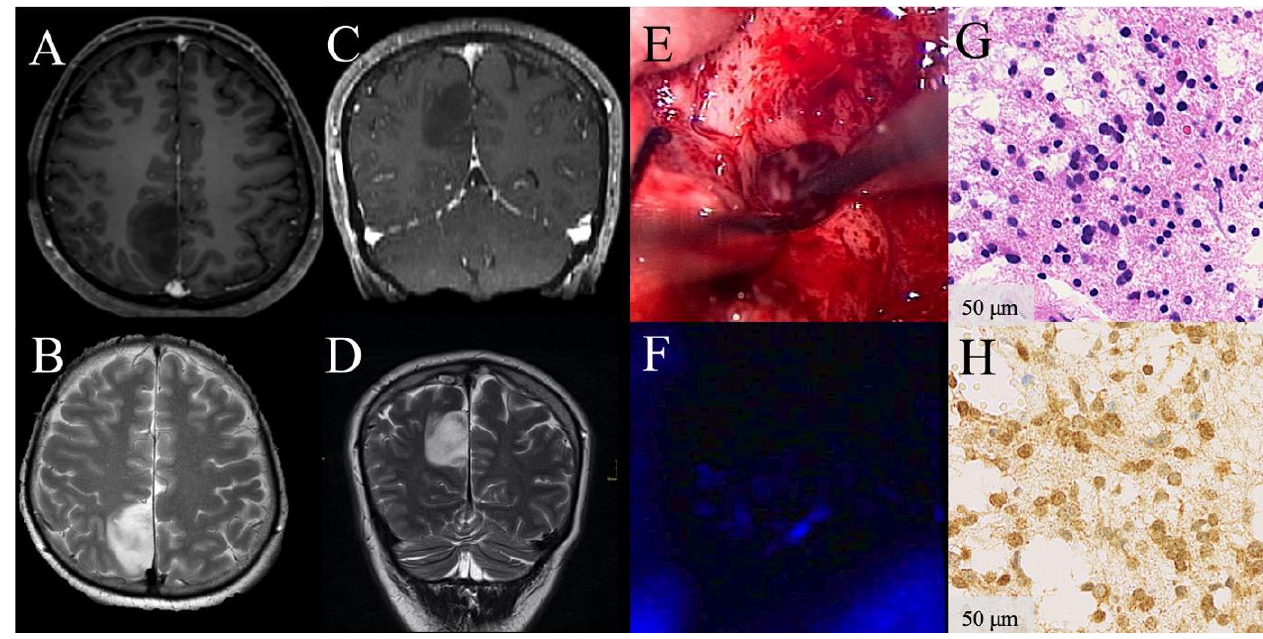
Figure 1. Illustrative clinical course of a patient with absence of visible 5-aminolevulinic acid (5-ALA) florescence during surgery of a low-grade glioma. Preoperative contrast-enhanced (CE) magnetic resonance images demonstrate a radiologically suspected LGG in the parietal lobe with patchy/faint CE on T1-weighted axial ( A ) and coronal images ( C ) and hyperintensity on T2-weighted sequences ( B , D ). Under white-light microscopy whitish glioma tissue is shown ( E ). Under violet-blue excitation light, no 5-ALA fluorescence is visible during the entire procedure ( F ). The corresponding histopathological sample from this non-fluorescing area reveals diffusely infiltrating astrocytoma WHO grade II tissue according to the WHO 2016 criteria in the H&E stain ( G ). Immunhistochemical staining for IDH mutation is highly positive ( H ). In the postoperative follow-up, this patient is still alive, more than 11.3 years after initial surgery.